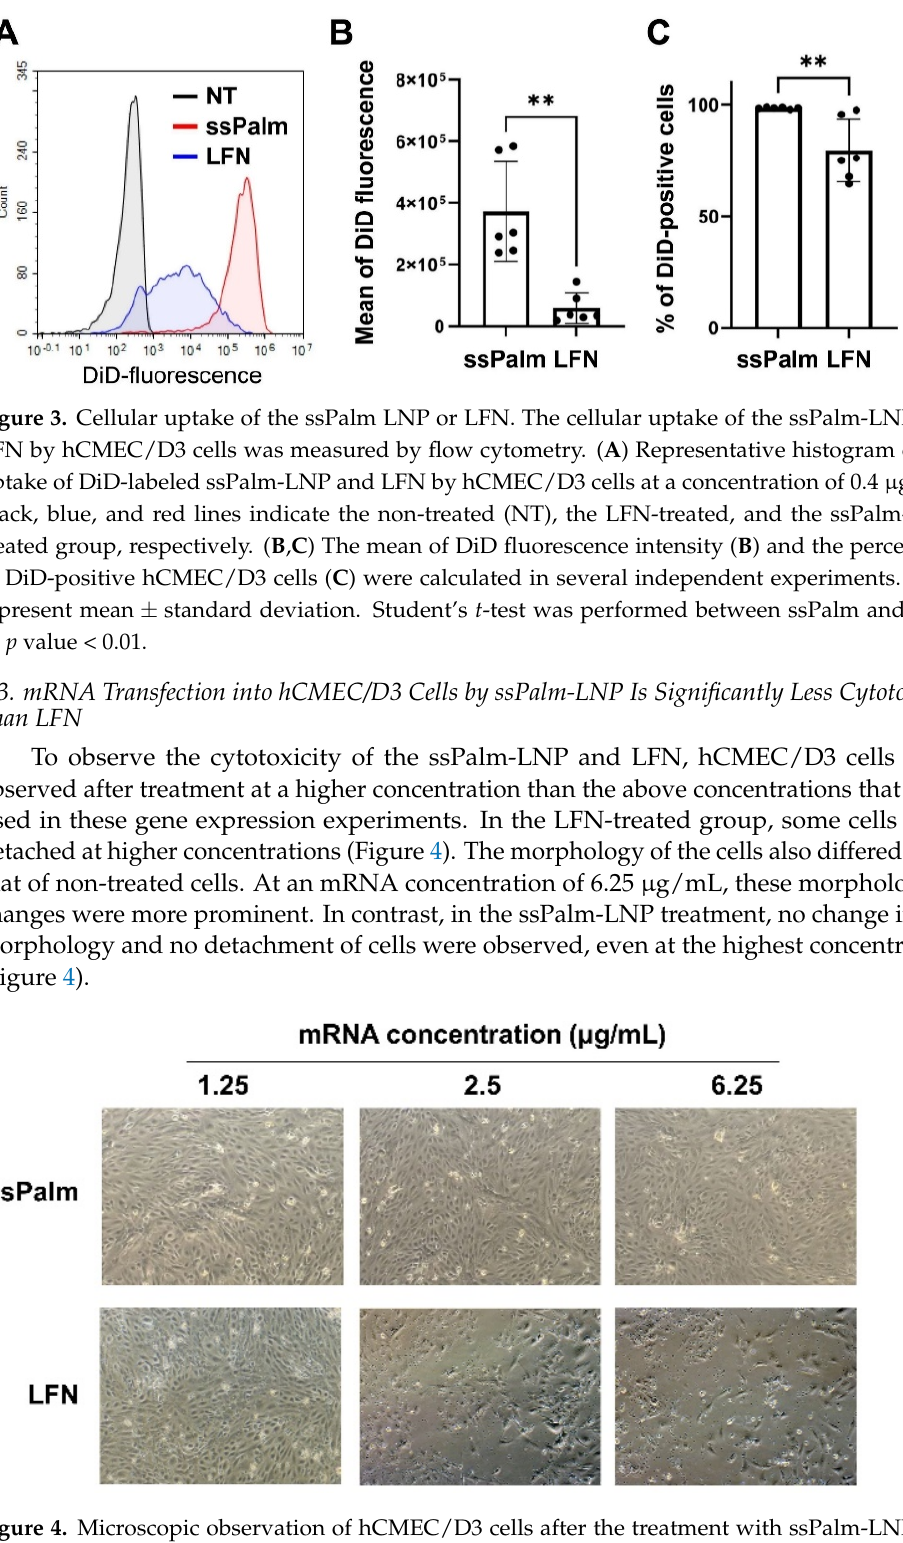
LFN. The ssPalm-LNP and the LFN were treated with hCMEC/D3 cells for 48 h at the indicated